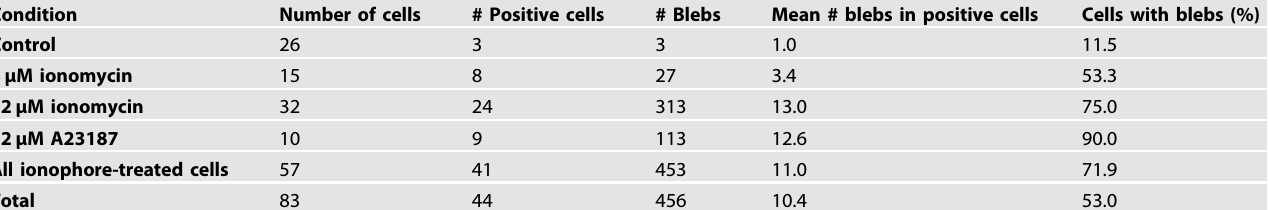
Table 3. Summary of bleb data across cell conditions after 2 h exposure to calcium ionophore or control media.